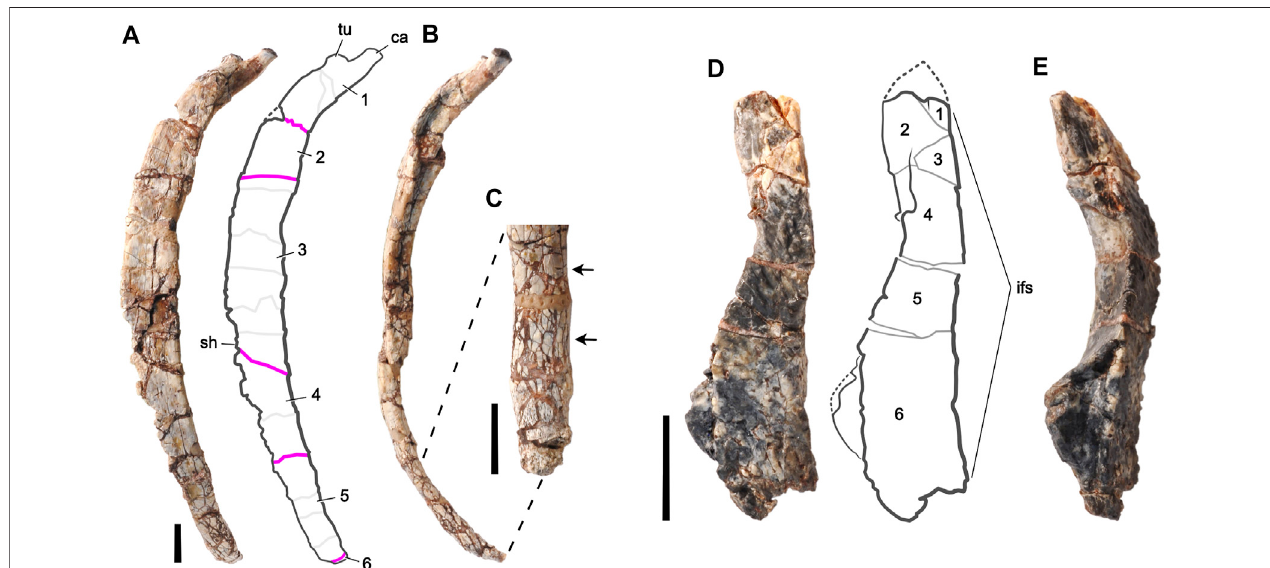
FIGURE 2 | Fossil bones of an unnamed basal thyreophoran dinosaur from Niger used for digital restoration. Right middle dorsal rib (J111) in (A) lateral and (B) anterior views, and a magni fi ed view of its distal end in (C) medial view. The proximal end is at the top. Left frontal bone (H100-3) in (D) dorsal and (E) lateral views. The anterior end is at the top. Rib fragments are numbered and separated by pink lines; minor fractures are shown aslightgray lines. Arrows highlight small-scale fracturing, which can slightly increase rib diameter (lower arrow). Frontal fragments are numbered and separated by gray lines. Missing pieces are bounded by dotted lines. Abbreviations: ca, capitulum; if, interfrontal suture; sh, shaft; tu, tuberculum. Scale bars equal 1